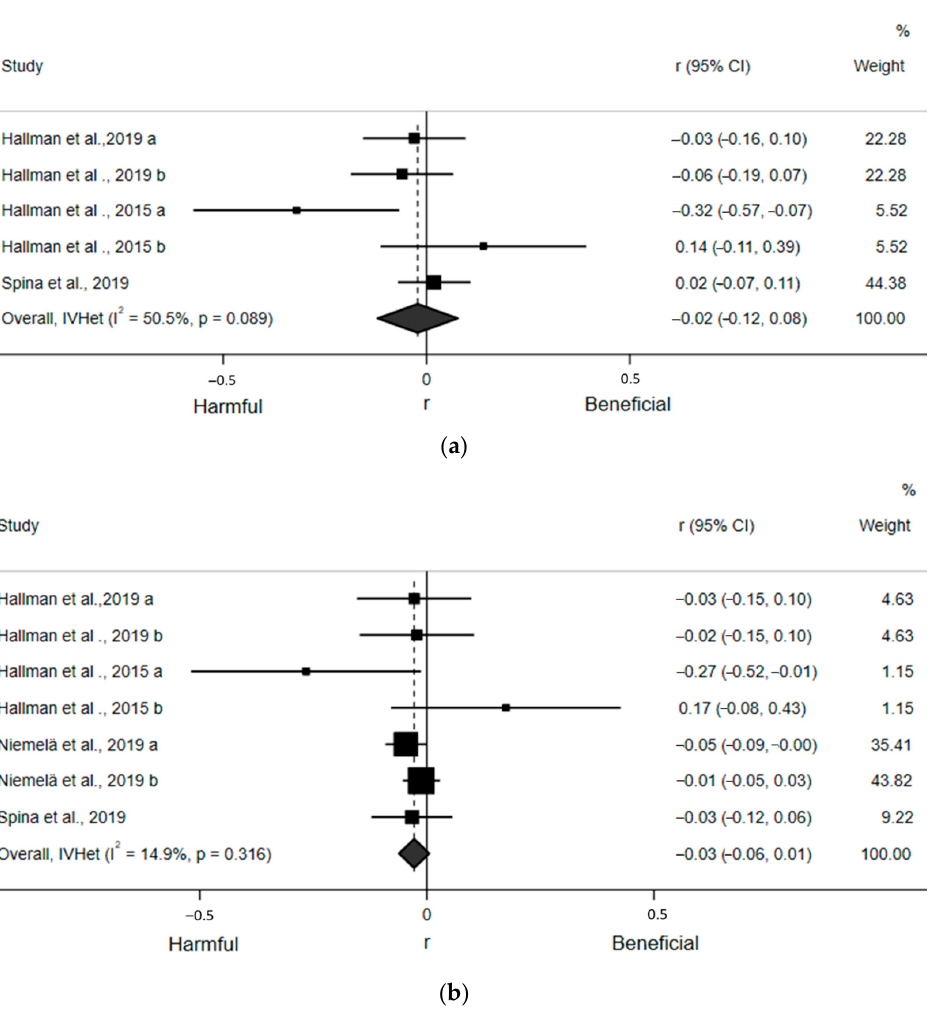
Figure 3. Forest plots of articles examining the association between ST and time domain indices of HRV. ( a ) Association between ST and SDNN. ( b ) Association between ST and RMSSD.